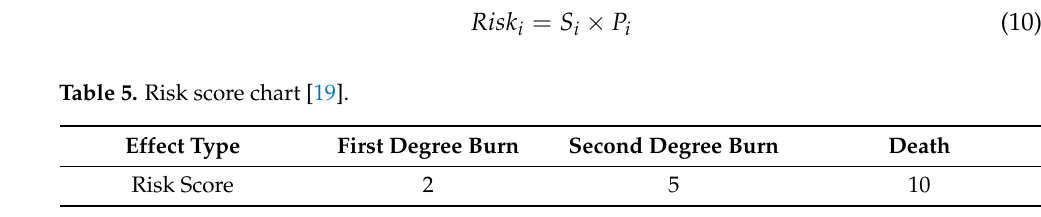
Table 5. Risk score chart [19].